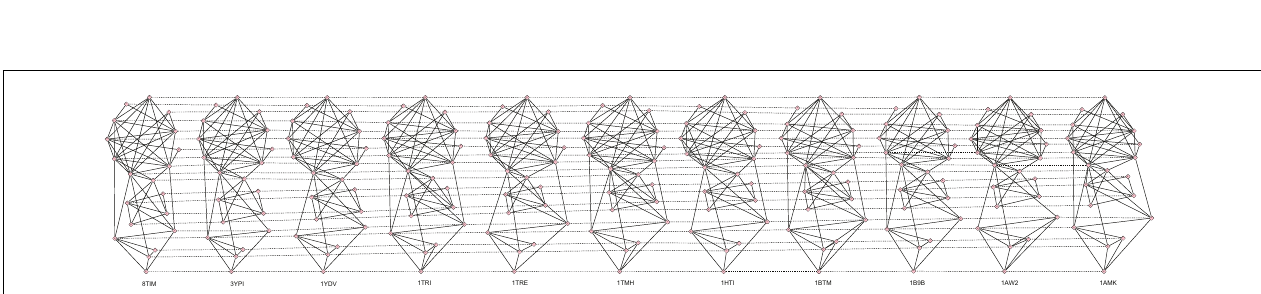
FIGURE 4 | Best alignment of the 8 Plastocyanin contact maps with W = 15.